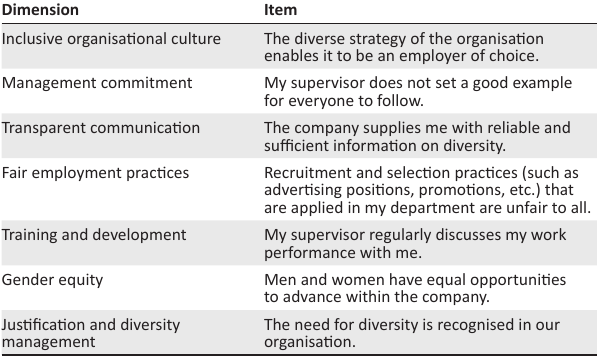
TABLE 2: Example of employment equity items measured.